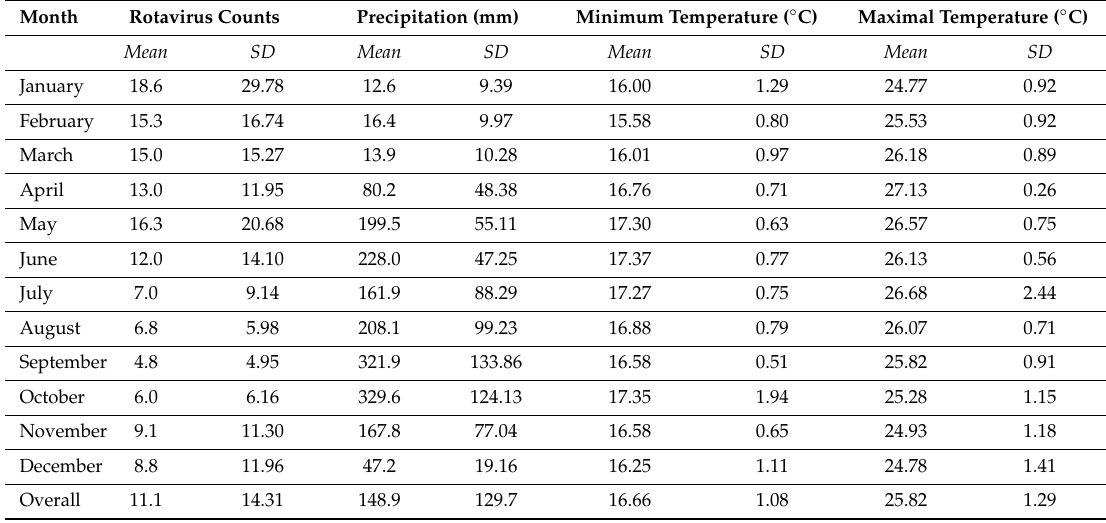
Table 1. Summary statistics for monthly values (mean and standard deviation) of rotavirus counts and meteorological parameters: precipitation, minimum and maximal temperature, for 2010–2015 in the Central Valley of Costa